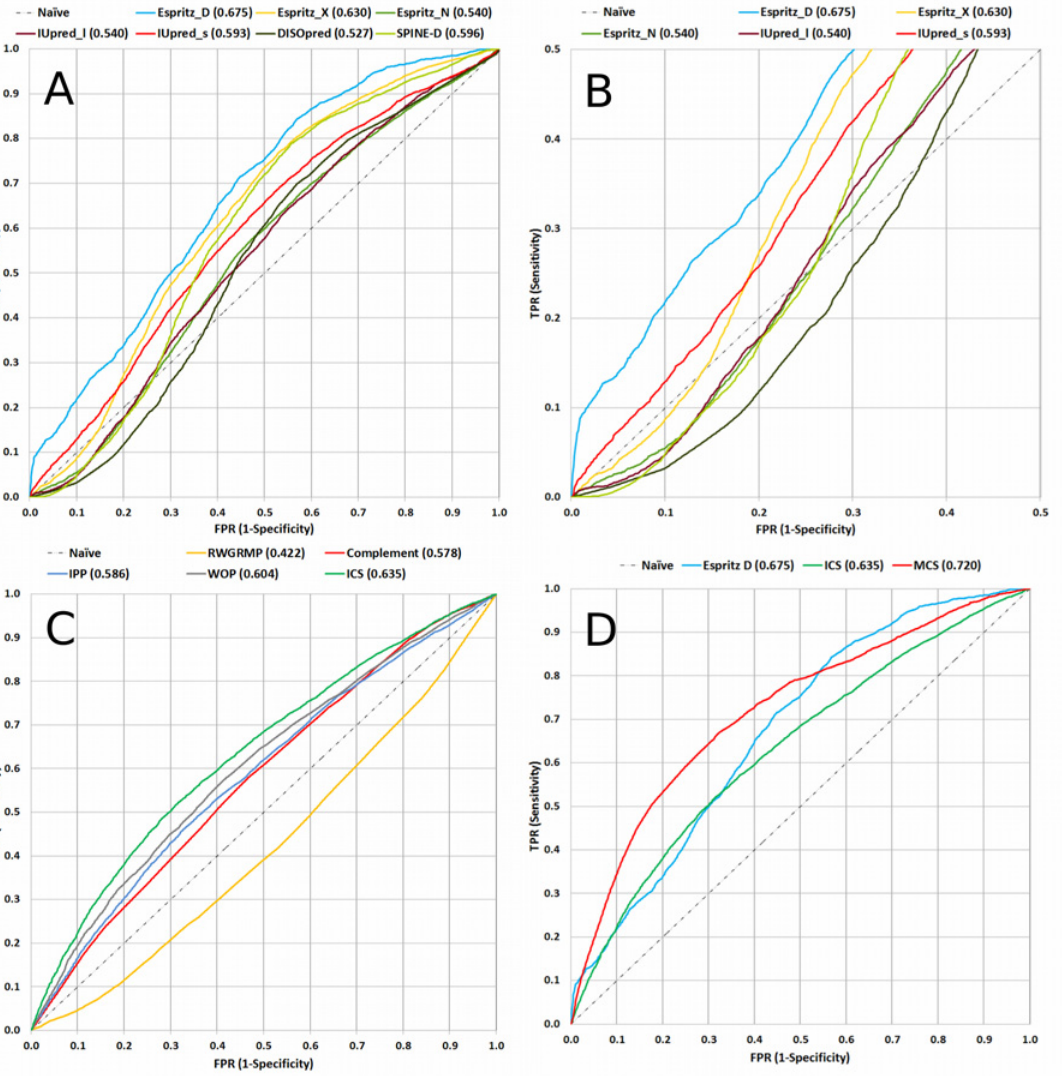
Fig 2. ROC MoRF curves of multiple prediction tools. Vertical axis is the true positive rate (TPR) and horizontal axis is the false positive rate (FPR). AUC MoRF values are in parentheses next to each label. (A) ROC MoRF curves of seven IDP predictors: DISOPRED (in black), ESpritz with the DisProt option (ESpritz_D in blue), ESpritz with the X-Ray option (ESpritz_X in yellow), ESpritz with the NMR option (ESpritz_N in green), IUPred with the long option (IUPred_l in brown), IUPred with the short option (IUPred_s in red), and SPINE-D (in light green). (B) The lower left corner of the ROC MoRF curves for the seven IDP predictors. (C) ROC MoRF curves of IPP (in blue), WOP (in gray), RWGRMP (in yellow) and its complement (Complement, in red). The Initial conservation propensity score, ics , (in green) was generated by joining IPP, Complement and WOP using Bayes rule. (D) ROC MoRF curves of ESpritz_D (in blue), ics (in green) and mcs (in red). mcs values are generated by processing ics